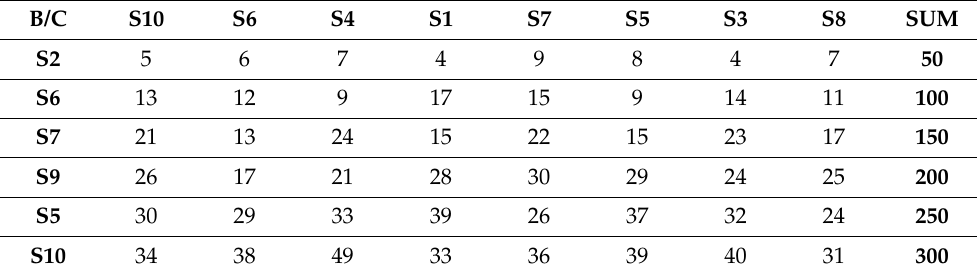
Table 3. Satellites transactions between Swarm B, and C (the size of a transaction is 3049